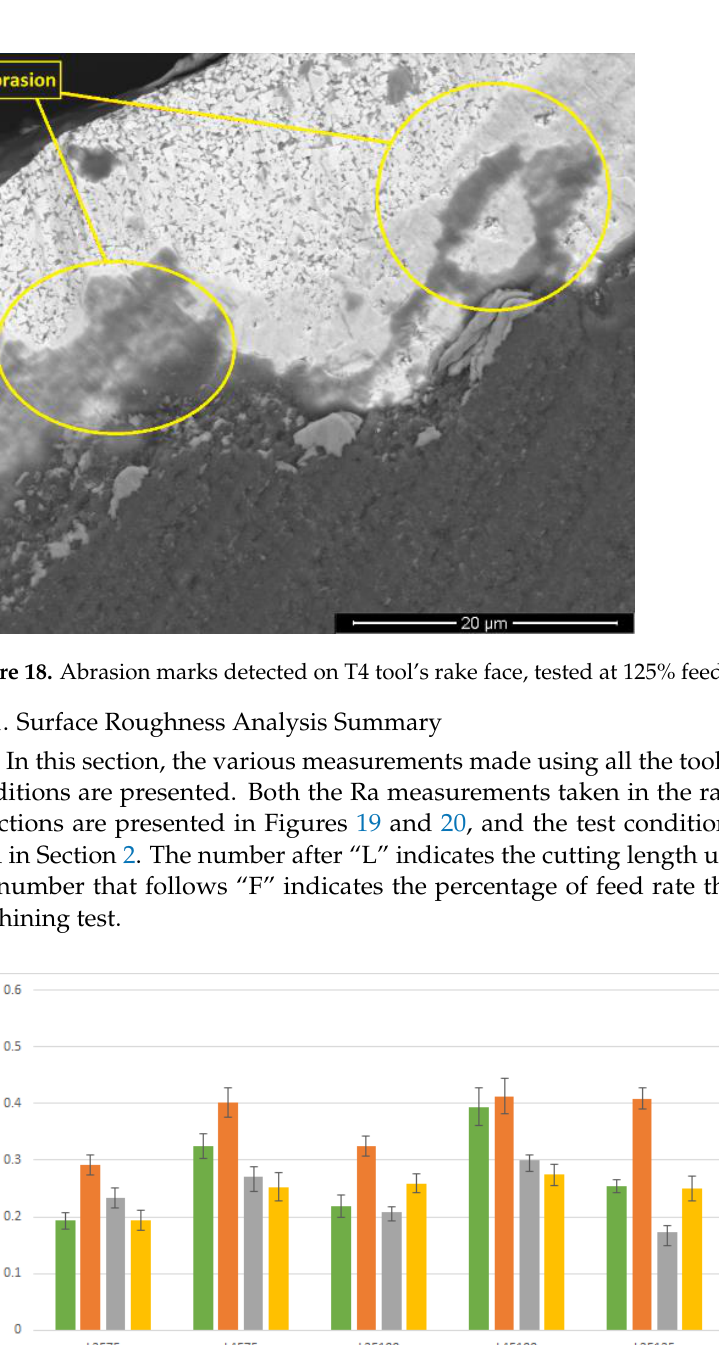
Figure 20. Average values of Ra, measured in the tangential direction, produced by T1, T2, T3 and T4 tools for all the different test conditions.